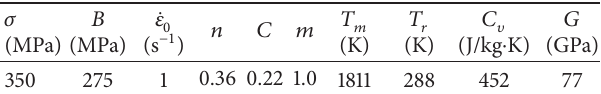
Table 2: Parameters in Johnson-Cook constitutive model of steel